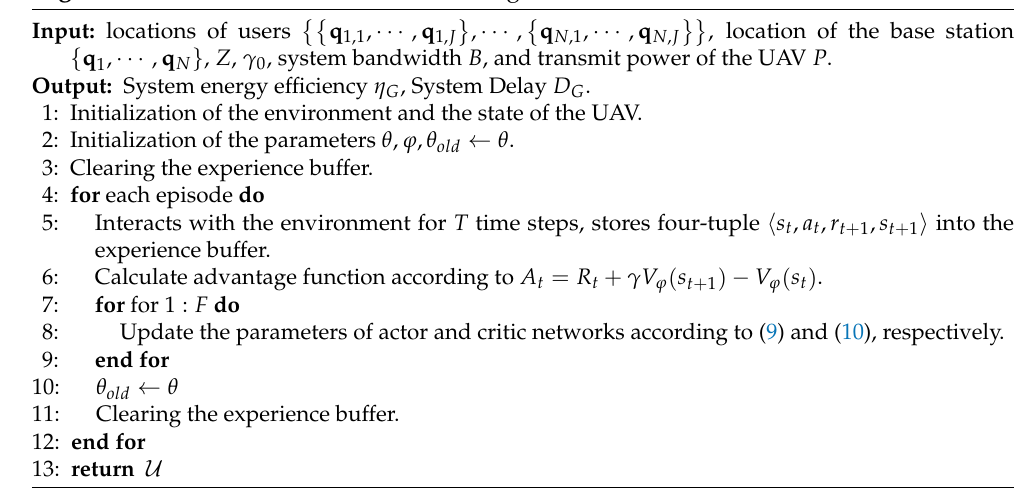
Algorithm 1 PPO-based Data Collection Algorithm.